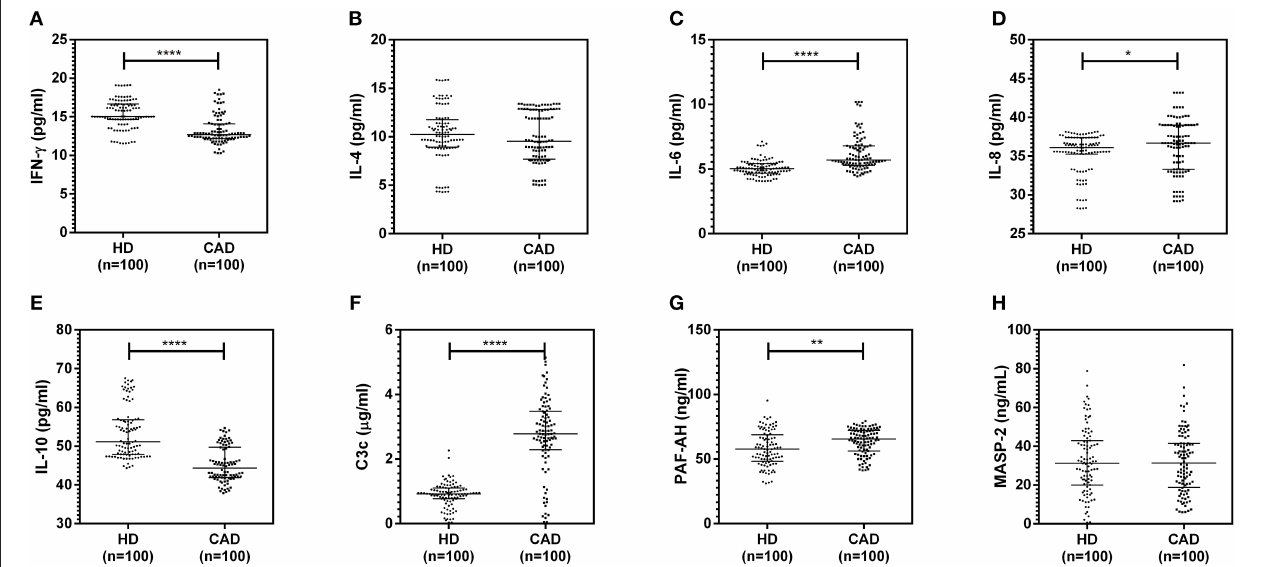
FIGURE 5 | Inflammatory and complement activation status in CAD patients (A–H) . Plasma levels of IL-4, IL-6, IL-8, IL-10, IFN- γ , C3c, and PAF-AH were measured by sandwich ELISA. Significantly higher complement activation, as assessed by C3c levels, IL-6, IL-8, and PAF-AH levels were observed in CAD patients compared to healthy donors. IFN- γ and IL-10 levels were significantly lower in CAD patients compared to healthy donors. Mann-Whitney U test was used for comparison of values between groups. One asterisk (*) indicates a p -value of < 0.05, two asterisks (**) indicate a p -value of < 0.01, and four asterisks (****) indicate a p -value of < 0.001.